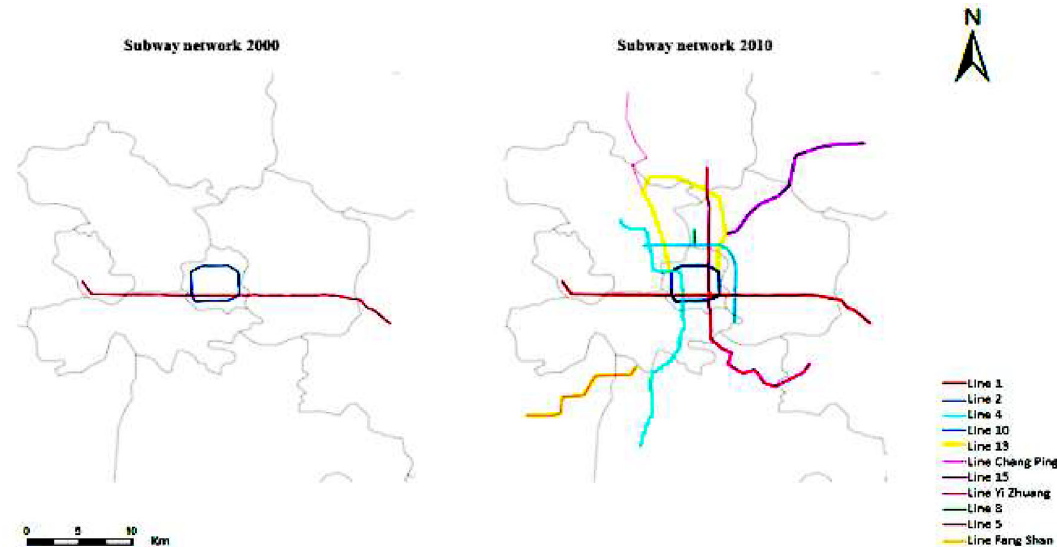
Fig. 2 Urban metro system expansion from 2000 to 2010 in Beijing metropolitan area